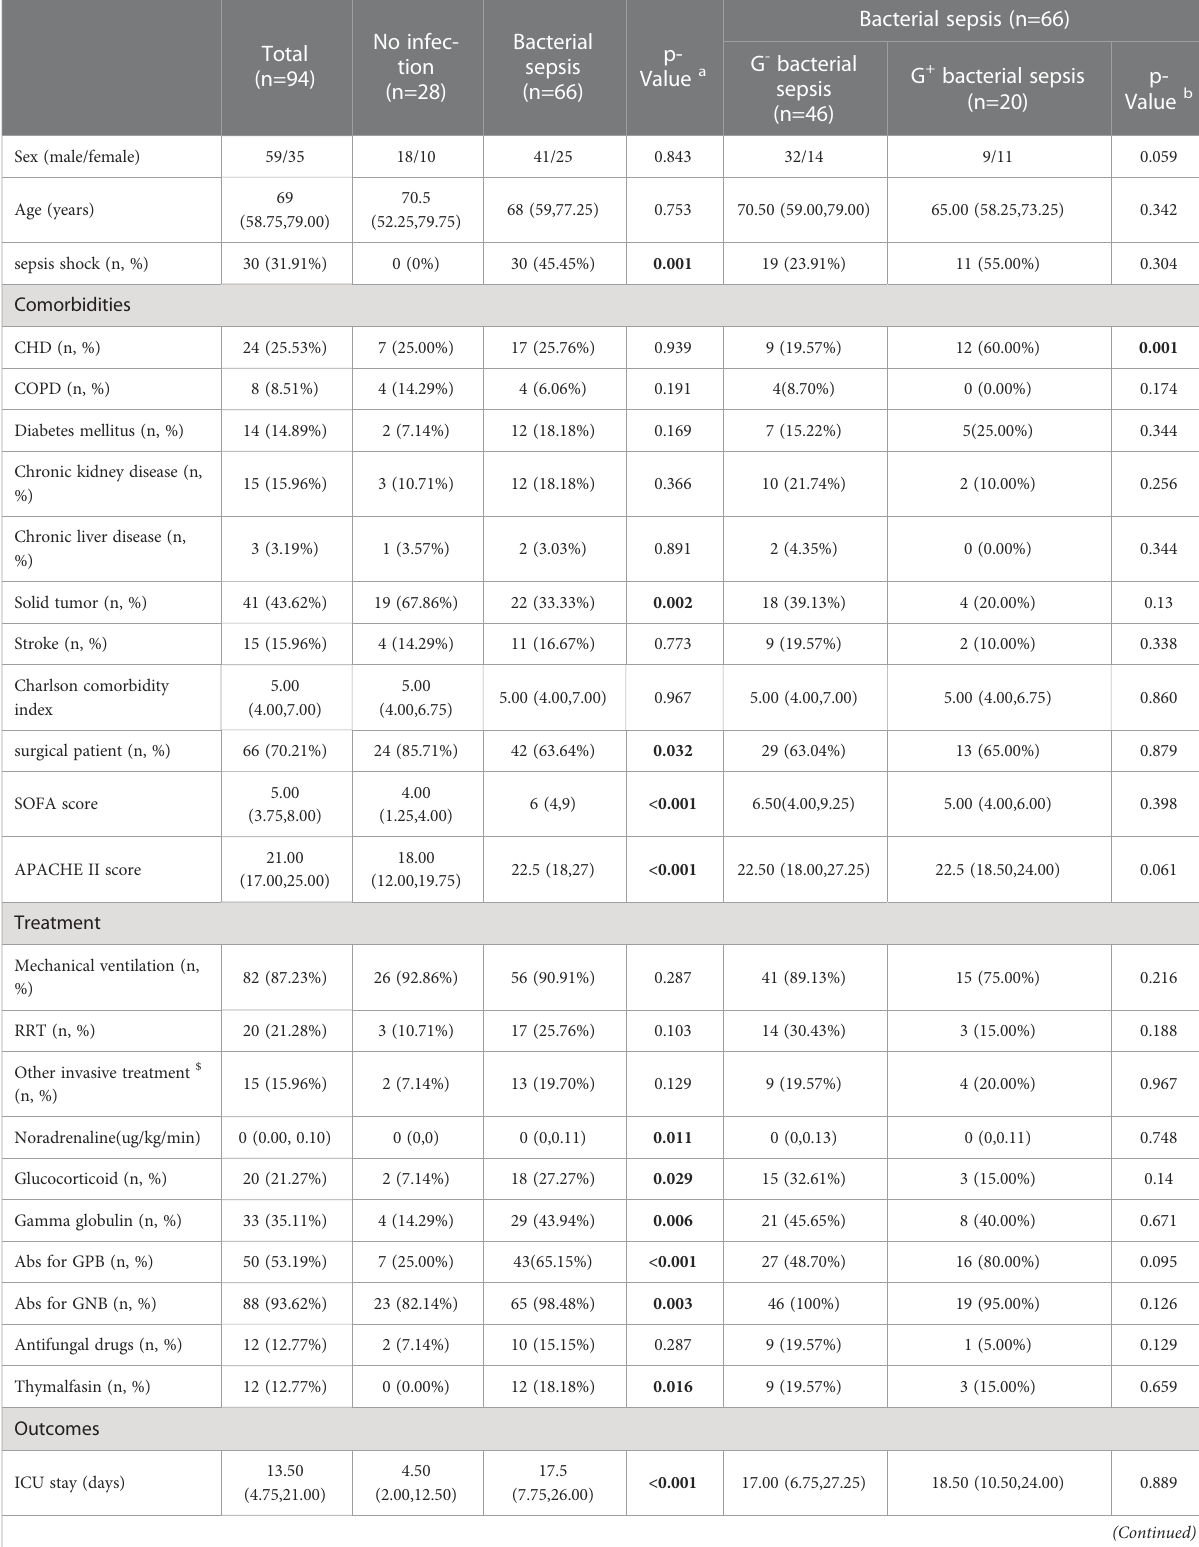
TABLE 1 Clinical characteristics of critically ill